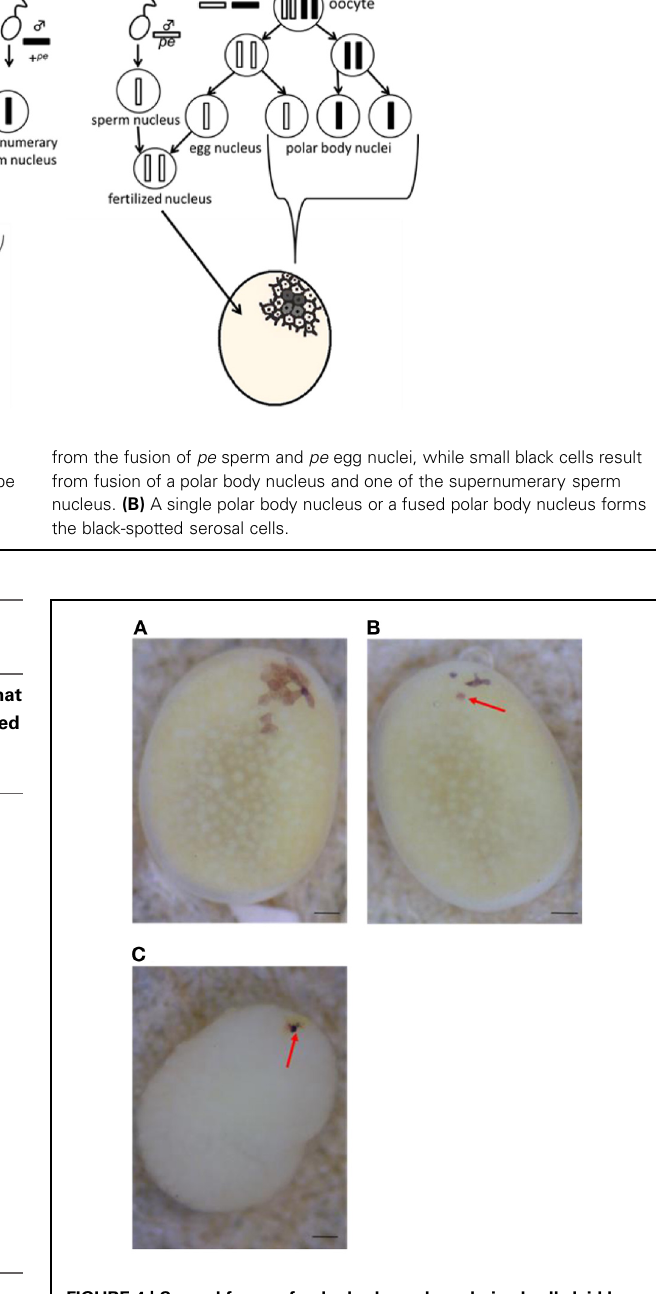
FIGURE 4 | Several forms of polar body-nucleus-derived cells laid by pe / + pe females crossed with pe / pe males. (A) White egg with a small number of fully black serosal cells. (B) White egg with an incompletely pigmented serosal cell (red arrow). (C) White egg with black granular tissues (red arrow); the chorion was removed. Scale bars represent 100 µ